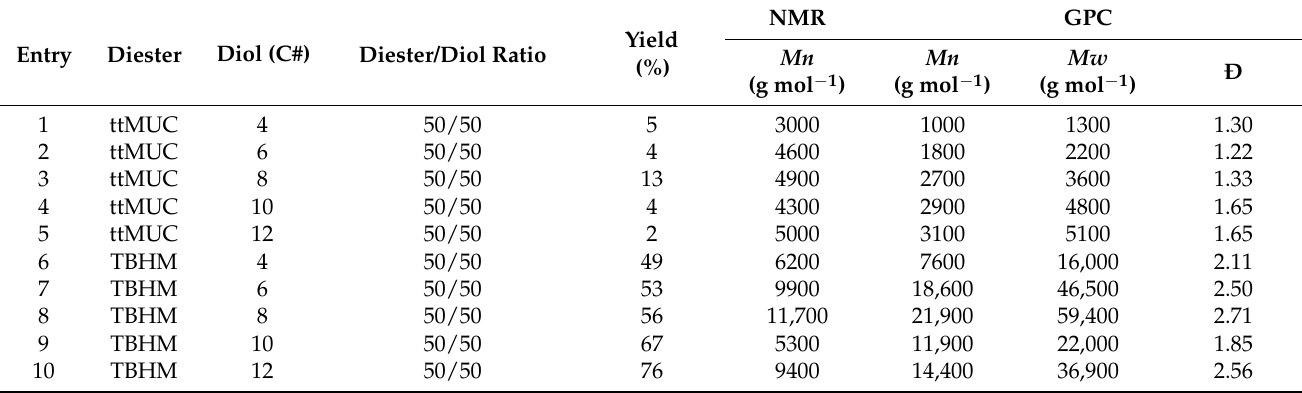
Table 1. Yield and molar mass of polymers obtained from the polymerization of unsaturated aliphatic diesters and diols with various carbons between 4 and